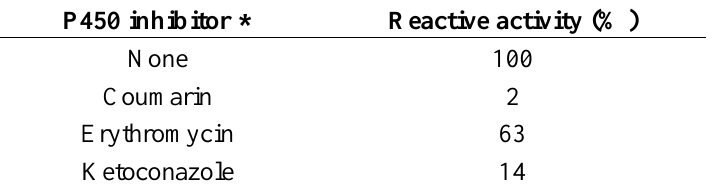
Table 2. Effect of P450 inhibitors on hydroxylation of